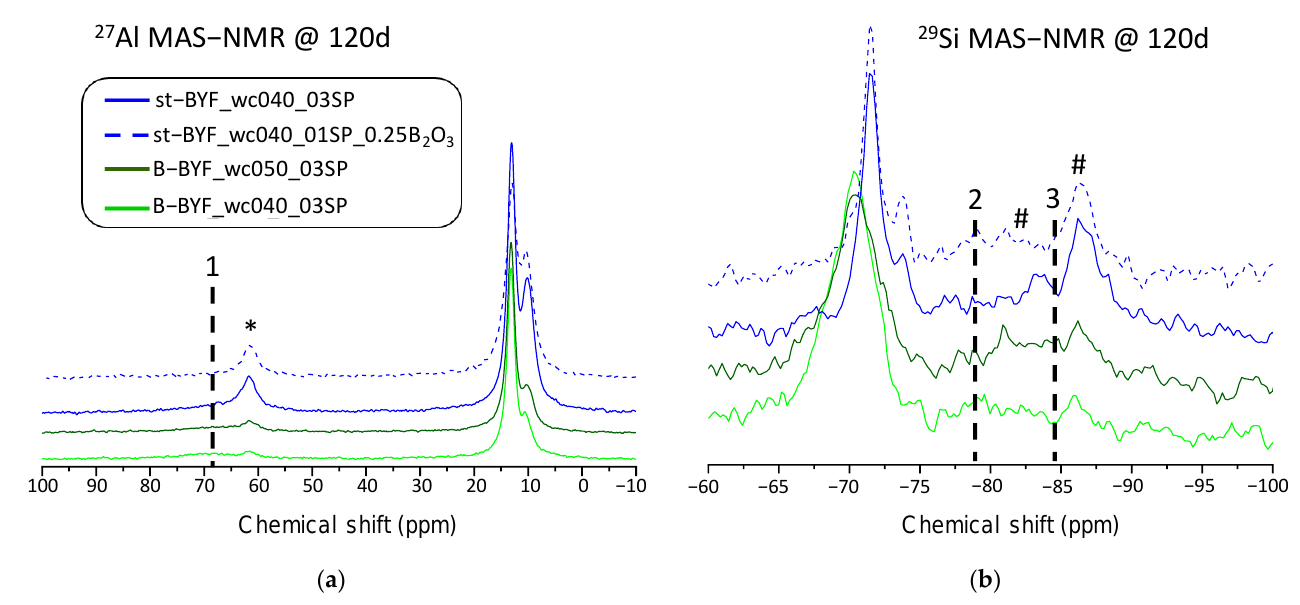
Figure 7. ( a ) 27 Al MAS-NMR and ( b ) 29 Si MAS-NMR spectra for selected pastes after 120 days of hydration. Asterisk indicates the interlayer IV Al resonance due to stratlingite. # stands for Q 3 (2Al) and Q 2 (1Al) resonances of stratlingite. IV Al resonance in C-A-S-H gel is labelled as 1 in ( a ). Q 1 and Q 2 resonances due to C-S-H gel are labelled as 2 and 3 in ( b ).